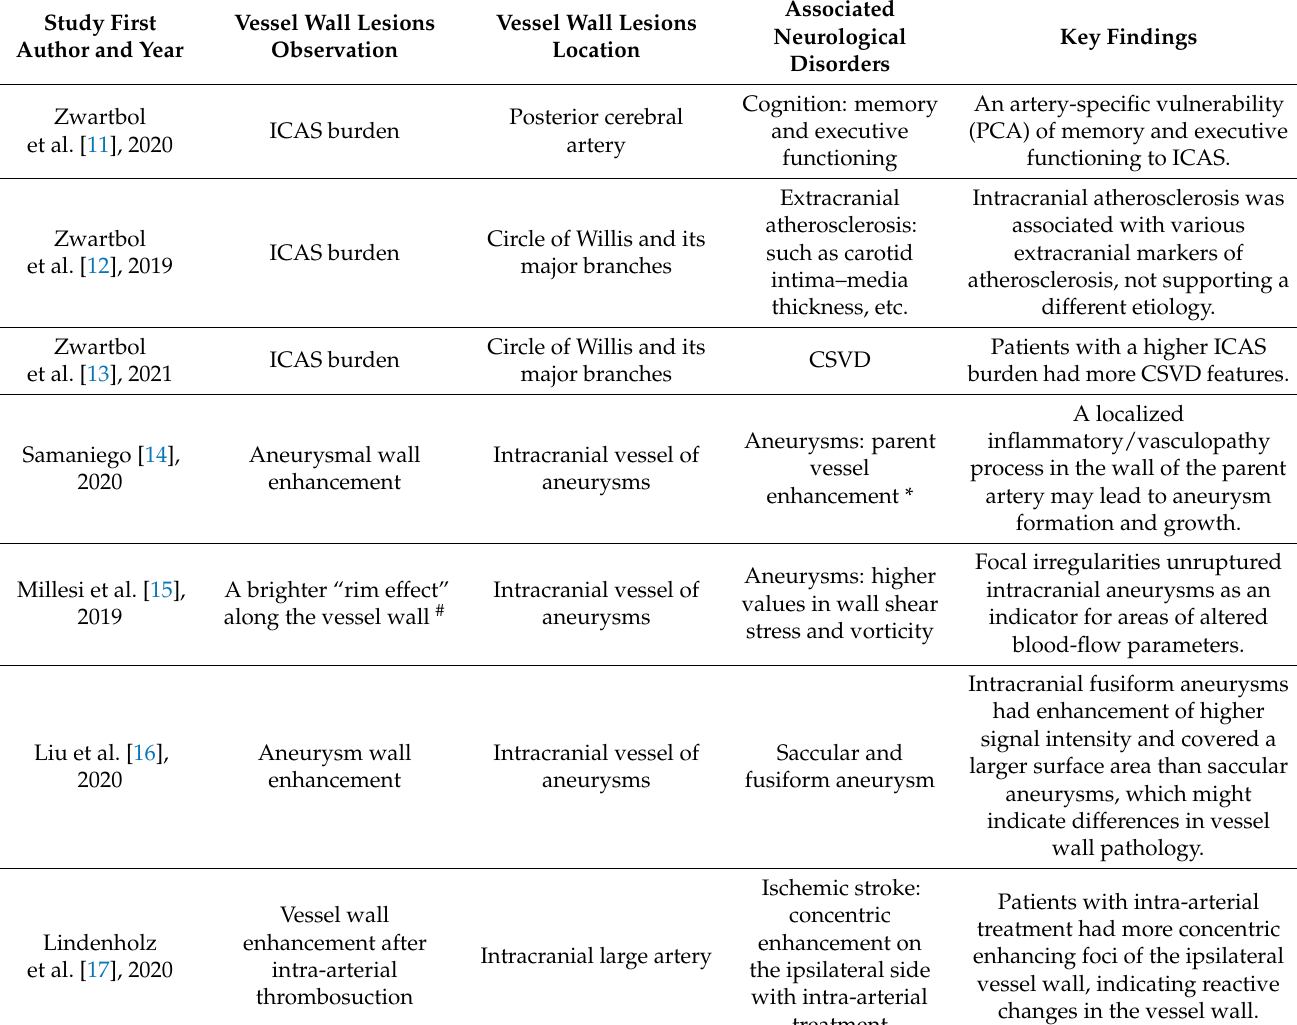
Table 2. Characteristics of intracranial vessel wall lesions and the associated neurological